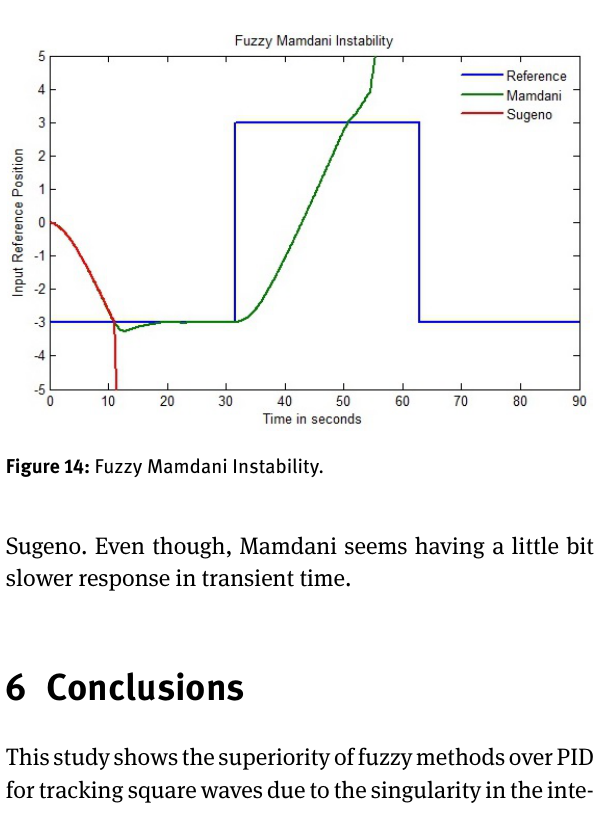
Figure 13: Fuzzy Sugeno Instability.